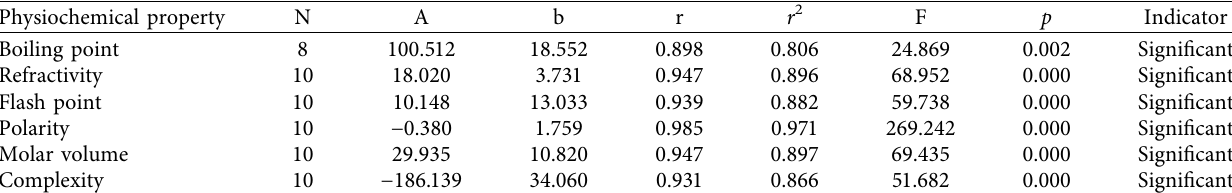
Table 4: Statistical parameters used in the QSPR model of R(G).